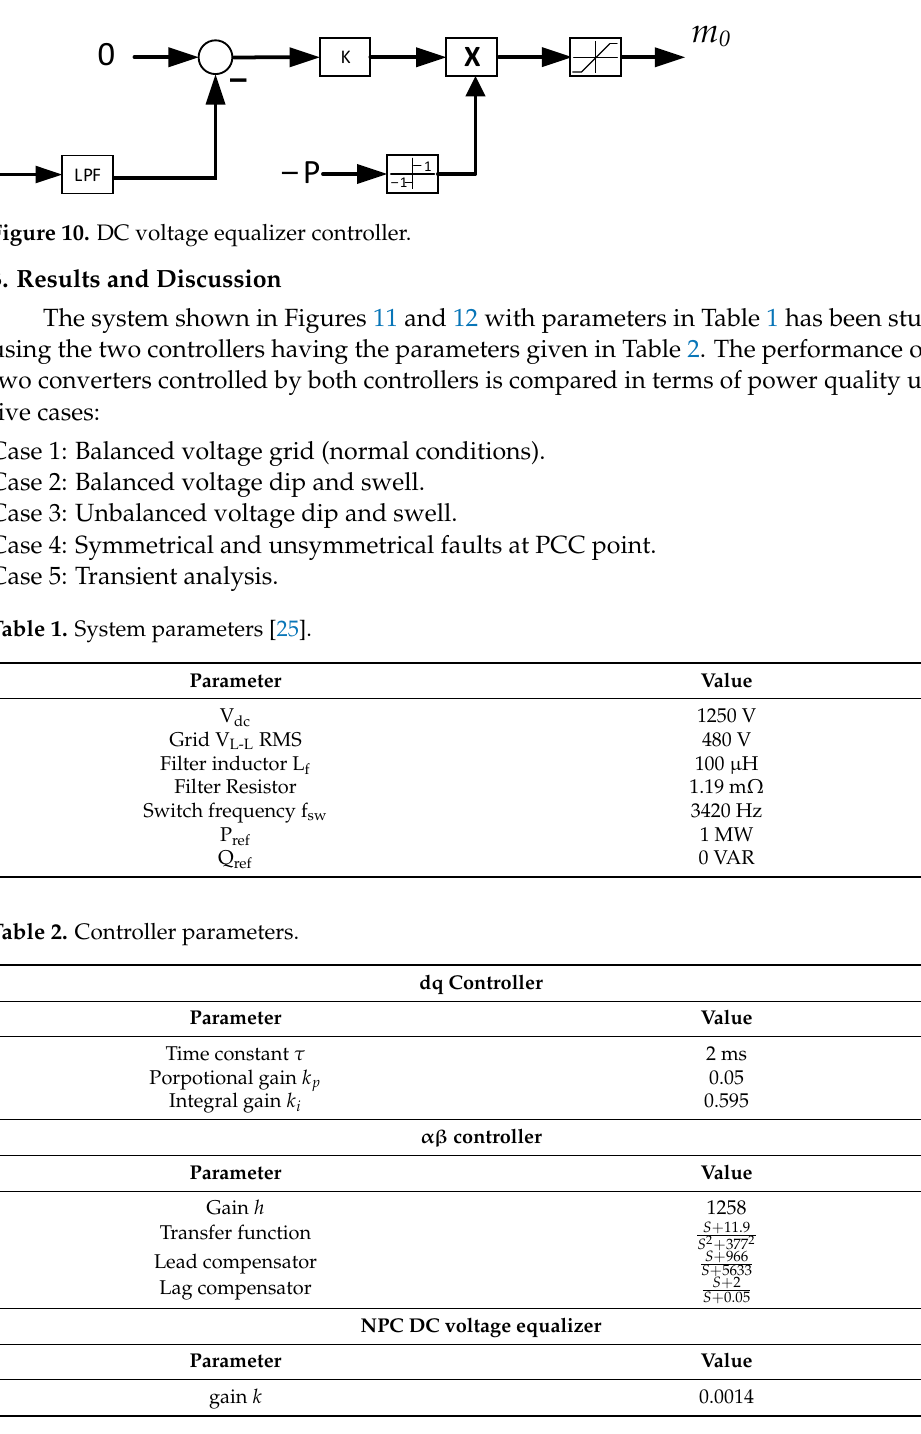
Table 2. Controller parameters.